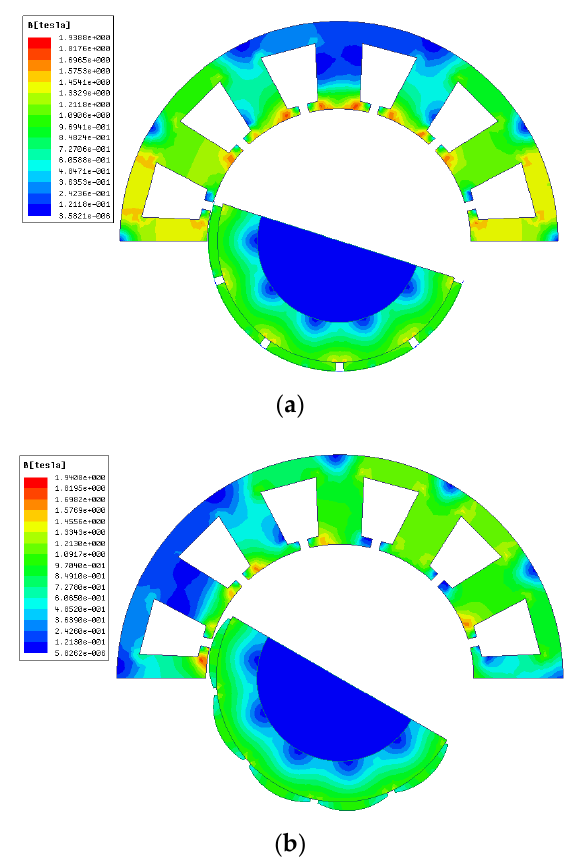
Figure 5. The magnetic field distribution in the 12S ‐ 10P motor. ( a ) Initial magnet shape; ( b ) Optimal magnet shape.